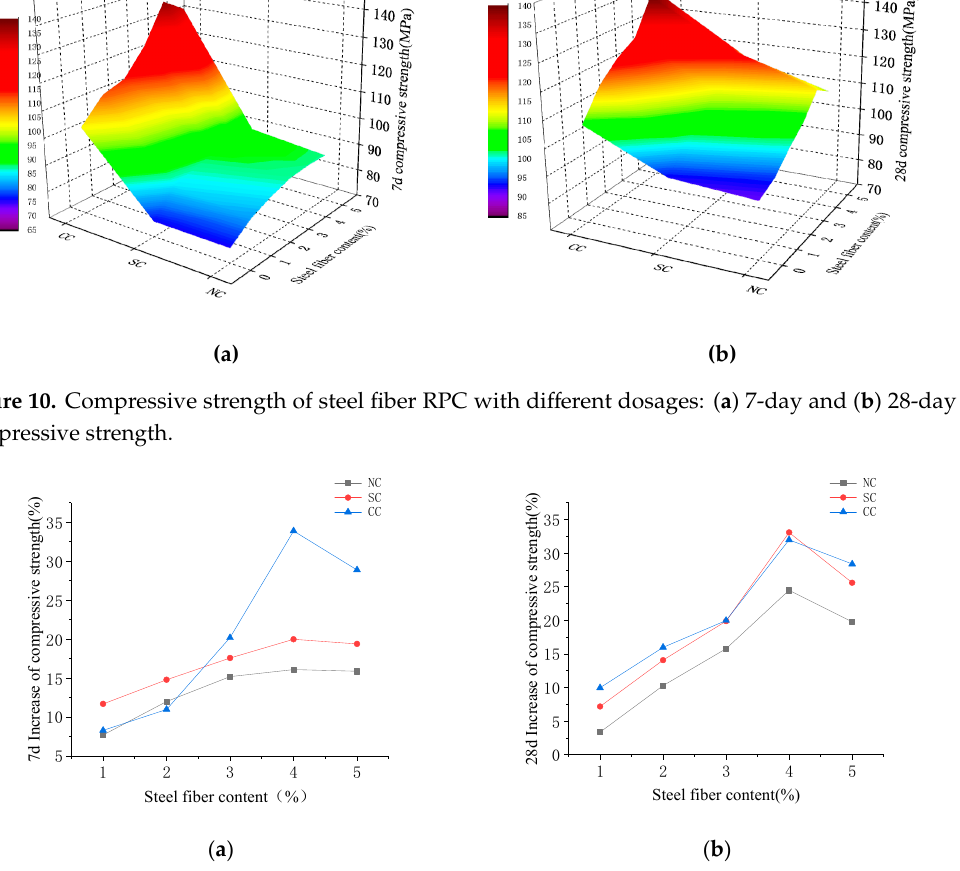
Figure 11 . Percentage of compressive strength improvement of steel fiber RPC with different dosages Figure 11. Percentage of compressive strength improvement of steel fiber RPC with di ff erent dosages